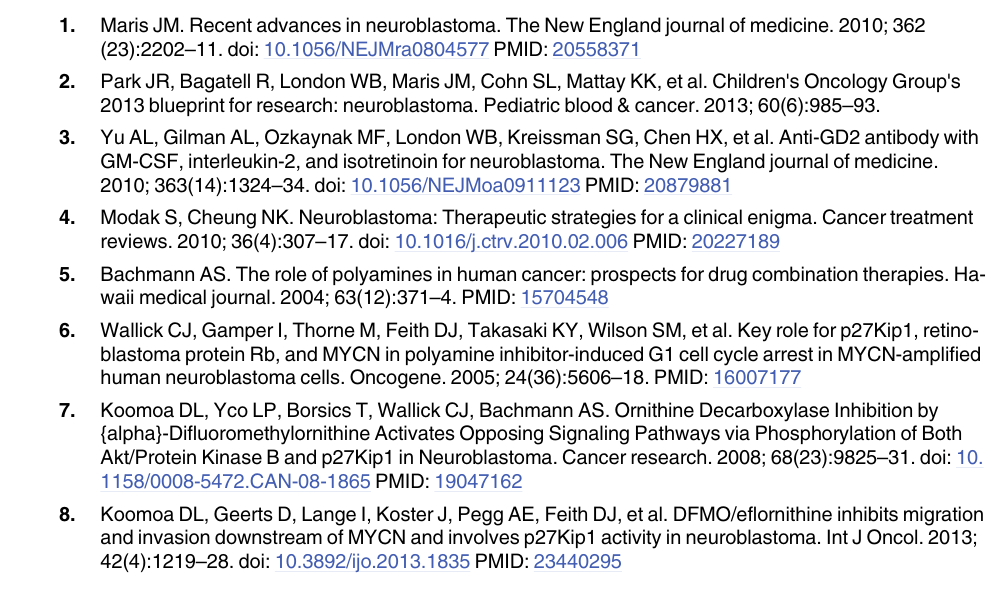
S1 Table. Enrollment Characteristics and Previous Relapse Therapies prior to